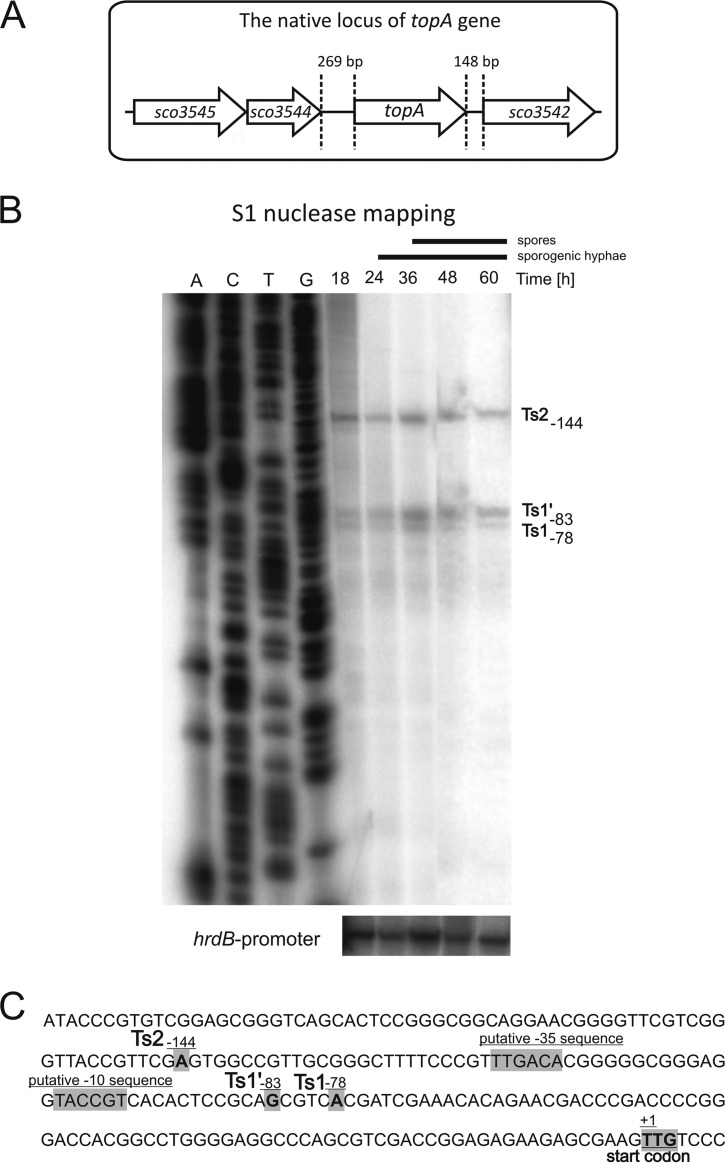
Identification of topA transcriptional start sites during S. coelicolor differentiation. (A) Map of the S. coelicolor chromosomal region in the vicinity of the topA gene (sco3543). (B) S1 nuclease mapping of topA transcripts. S1 mapping of the hrdB promoter region served as the mRNA control. (C) Sequence of the region upstream of topA. The identified Ts (transcription start) sites, the TTG translational start codon, and putative topAp1 promoter elements are marked in gray.